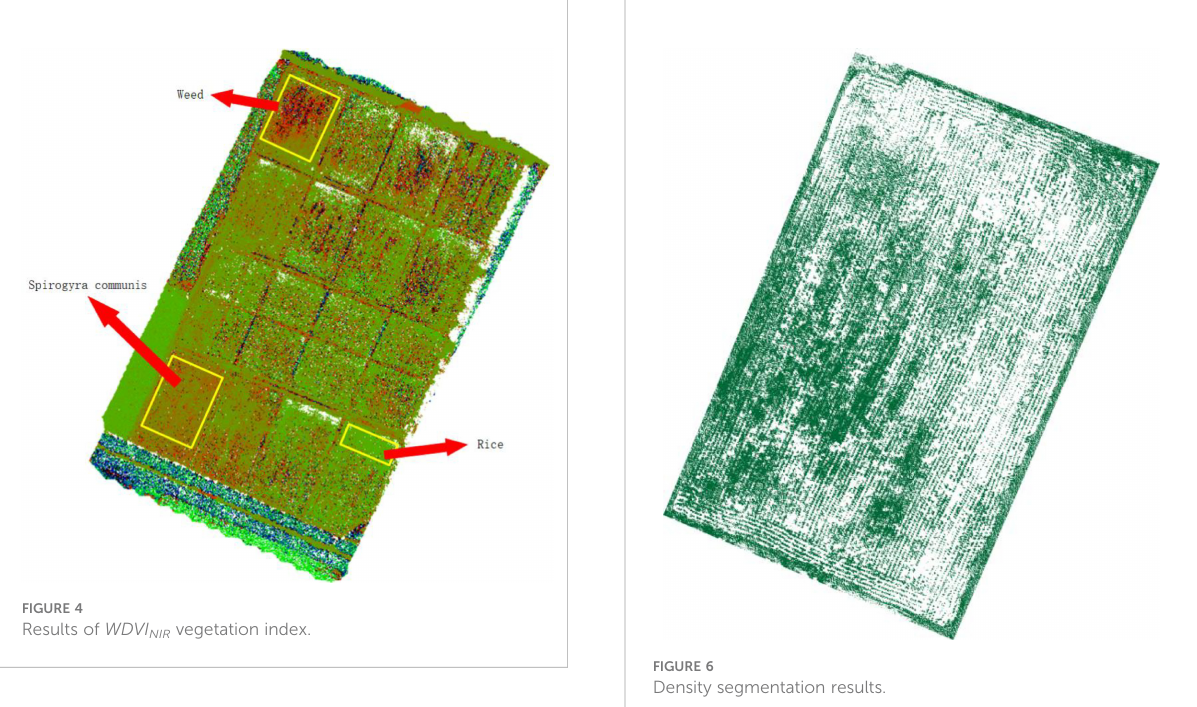
FIGURE 6 Density segmentation